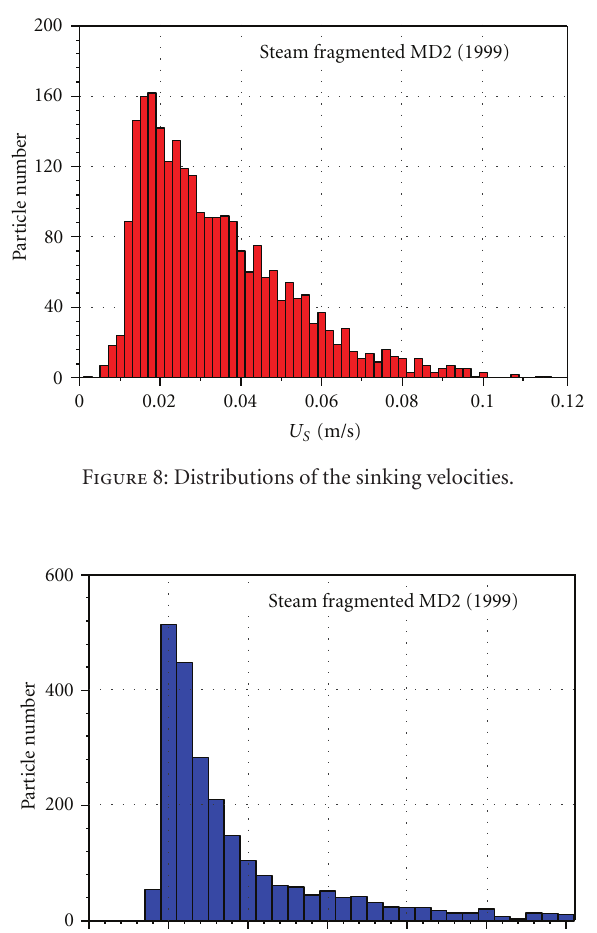
Figure 11: Accumulated fibre mass dependent on the inlet